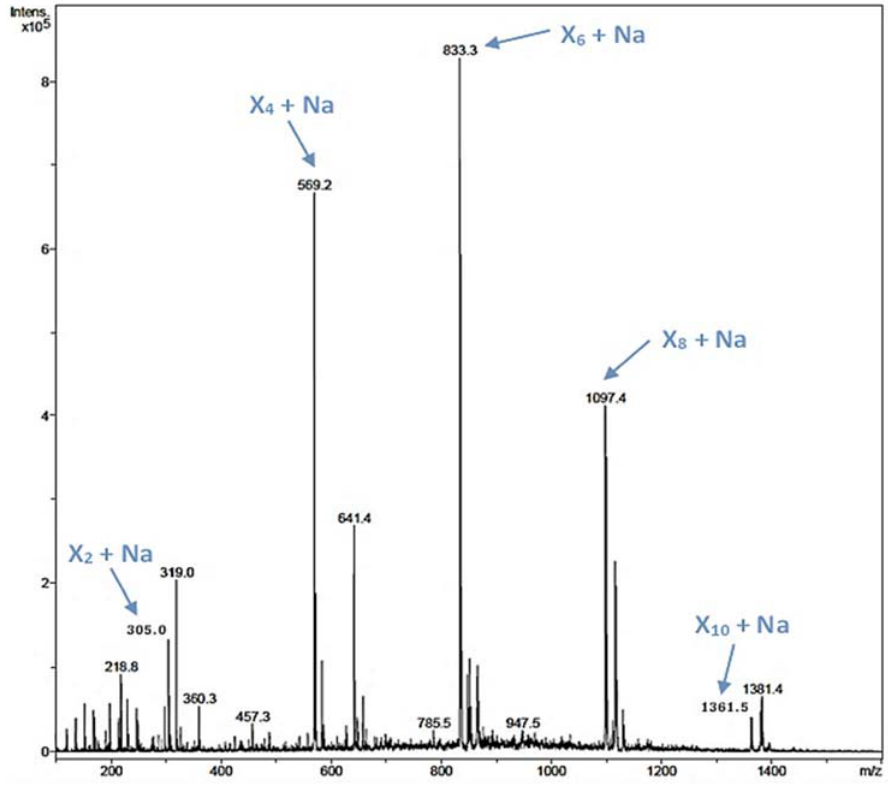
Figure 4. ESI-MS analysis of a reaction containing 20 mM X 2 F as the only reactant molecule and the glycosynthase variant rXynSOS-E236G as the catalyst. The m / z of ions corresponding to the Na adducts of xylooligosaccharides (XOS) of four, six, eight, and 10 xylose units (X 4 , X 6 , X 8 , and X 10 ) are indicated by blue arrows.